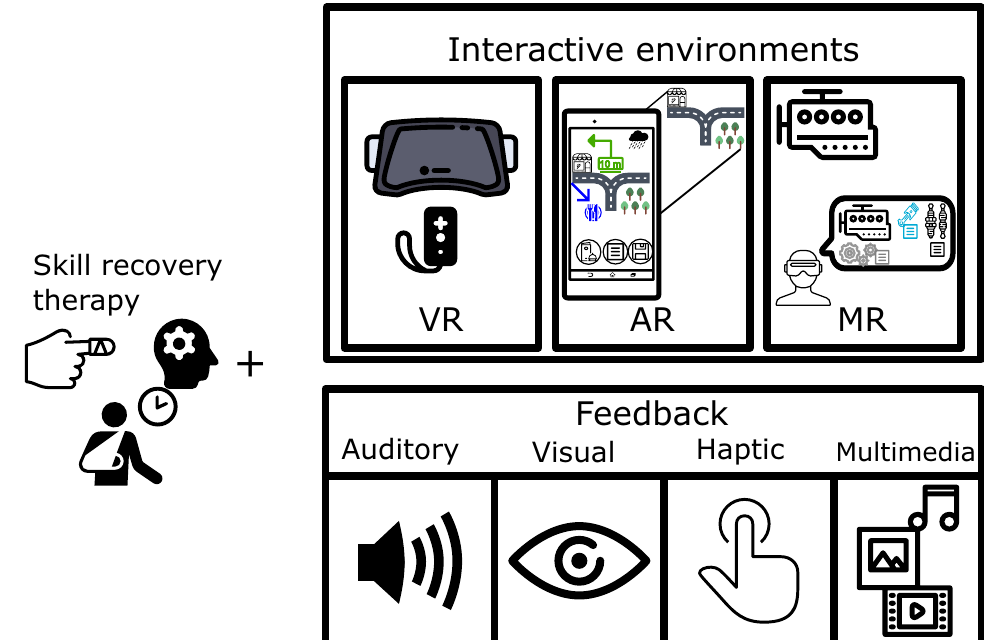
Fig. 3 Main components of the skill recovery systems presented in this